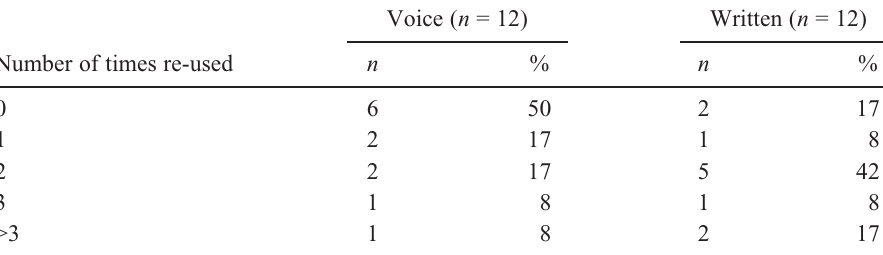
Table 4. Re-use of formative feedback after